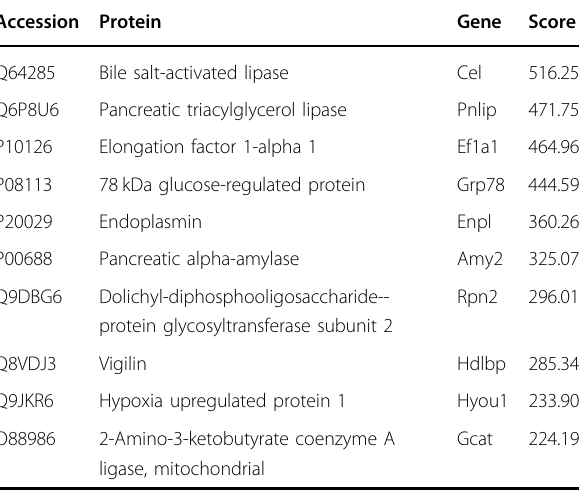
Table 1 Top 10 O-GalNac-modi fi ed proteins identi fi ed by VVA lectin precipitation coupled with LC-MS/MS proteome analysis. The complete table is available in the supplement Accession